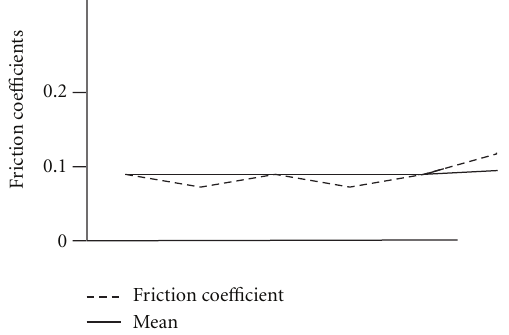
Figure 10: Results of an acetabulum friction